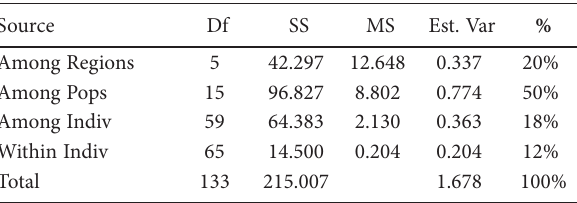
Table 5. The Nei genetic similarity ( G s) estimates using RAPD